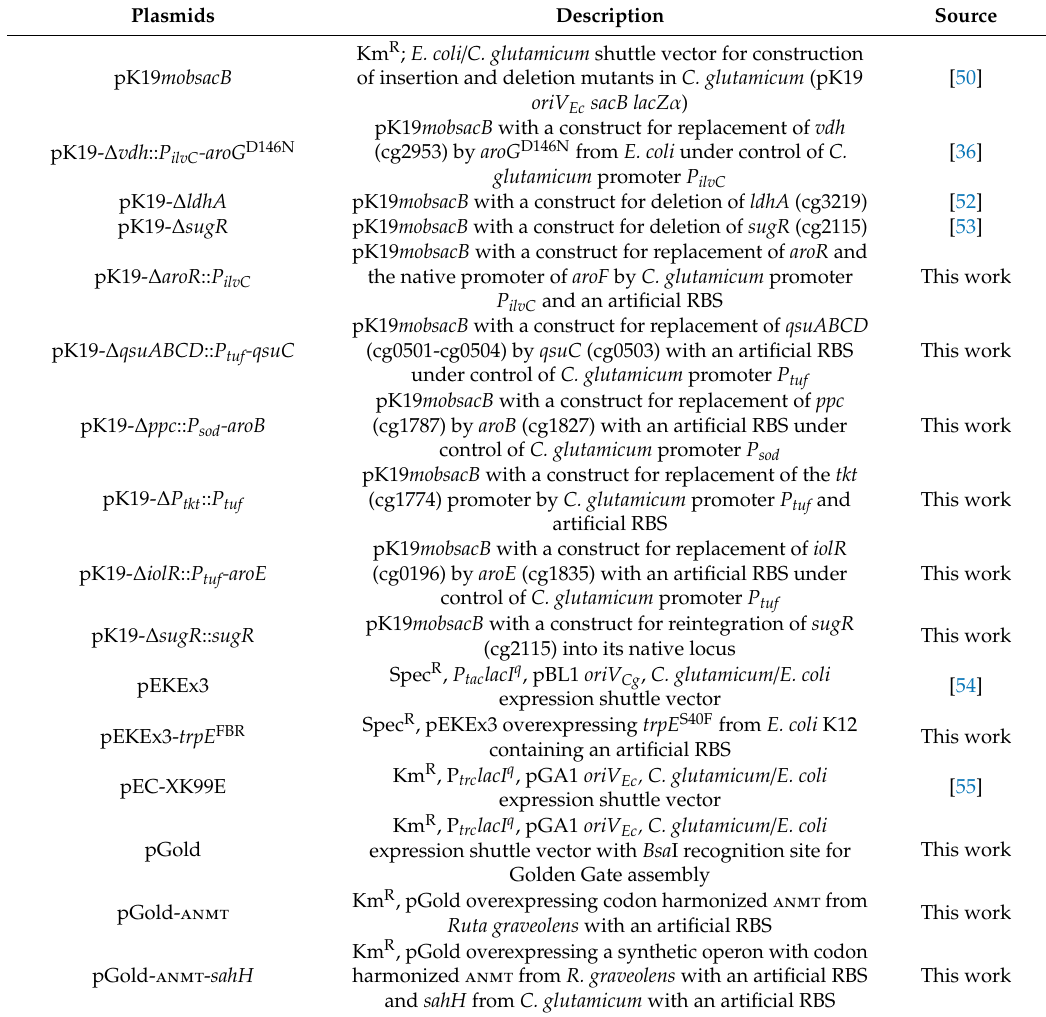
Table 3. List of plasmids used in this